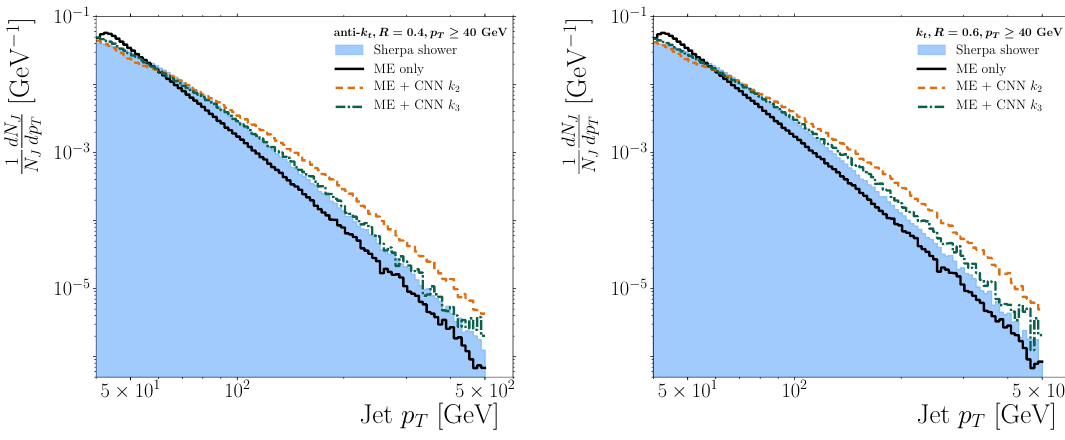
Figure 9 . Jet p T distributions using the anti- k t R=0.4 jet algorithm (left) and the k t R=0.6 algorithm (right).